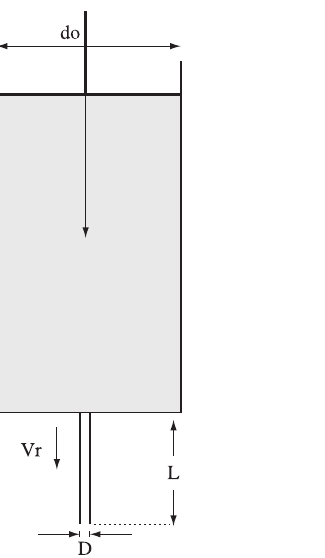
Figure 1. Capillary extrusion; D = 2R, Vr is the velocity of the ram, do = 2Rr and L is the length of the capillary.